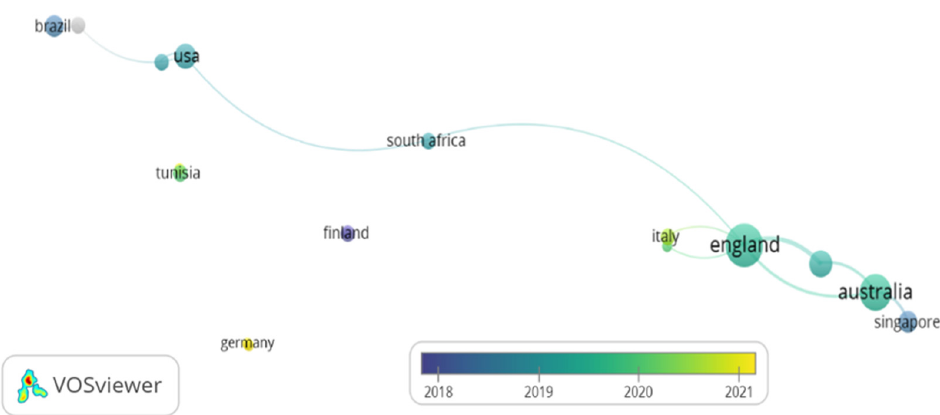
Figure 4. Countries involved in DfMA for construction research.